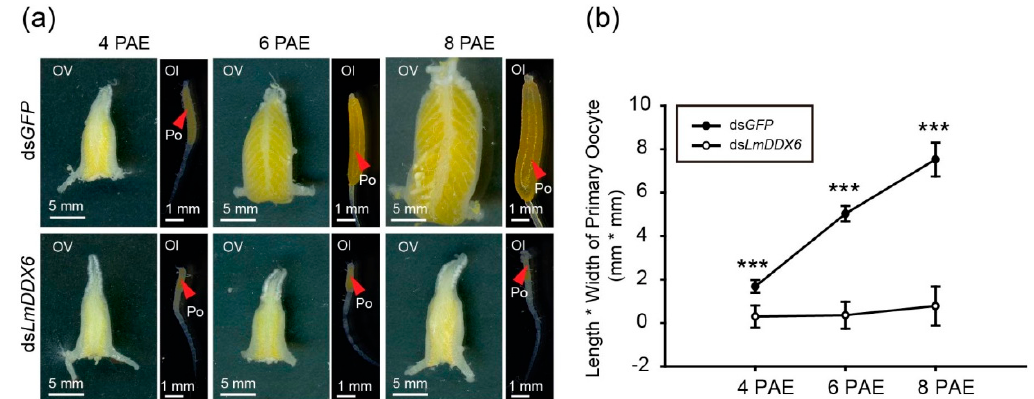
Figure 4. Effects of ds LmDDX6 treatment on locust ovary development and oocyte maturation. ( a ) Morphology of the ovaries (Ov) and ovarioles (Ol) in adult female locusts after injection of ds LmDDX6 or ds GFP . Ol, ovariole; Ov, ovary; Po, primary oocyte. PAE, days post adult eclosion. Scale bars: Ov, 5 mm; Ol, 1 mm. ( b ). The length × width index of primary oocytes from locusts injected with ds LmDDX6 or ds GFP at 4–8 days PAE. Data are presented as the mean ± standard error of the mean ( n = 8–13). Statistical significance of differences is indicated as follows: *** p < 0.001.